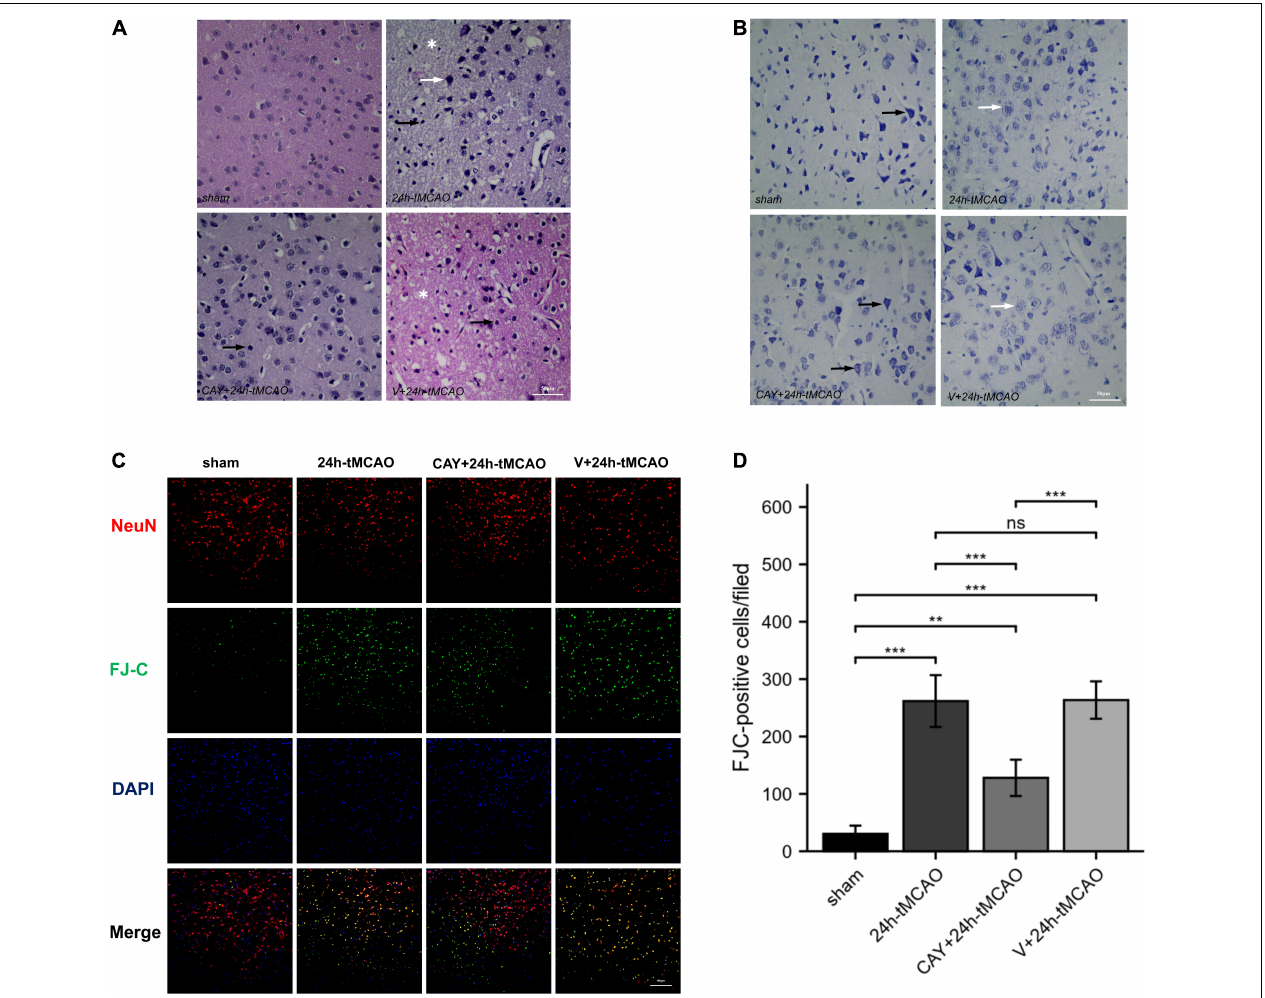
FIGURE 2 | H&E, Nissl and FJC staining in brain tissue of mice subjected to tMCAO after administration of an S1PR3-specific antagonist. (A) H&E staining in brain tissue of mice subjected to tMCAO after administration of an S1PR3-specific antagonist. Vacuolated neuropil in brain tissue (*). The black arrow points to the glial cells and the white arrow points to the nucleus of neurons that were reduced and trachychromatic ( → ), n = 4. Scale bar = 50 µ m. (B) Nissl staining in brain tissue of mice subjected to tMCAO after administration of an S1PR3-specific antagonist. The black arrow points to neurons with Nissl bodies. The white arrow points to neurons with absent Nissl bodies, n = 4. Scale bar = 50 µ m. (C,D) DAPI (blue)/FJC (green)/NeuN (red) Representative immunofluorescence images and statistical results of mouse brain tissue slices after tMCAO ( n = 4). Data are presented as the mean ± SEM. P -values were determined by ANOVA followed by the Tukey post hoc test, ** P < 0.01; *** P < 0.001; and ns, not significant. Scale bar = 100 µ